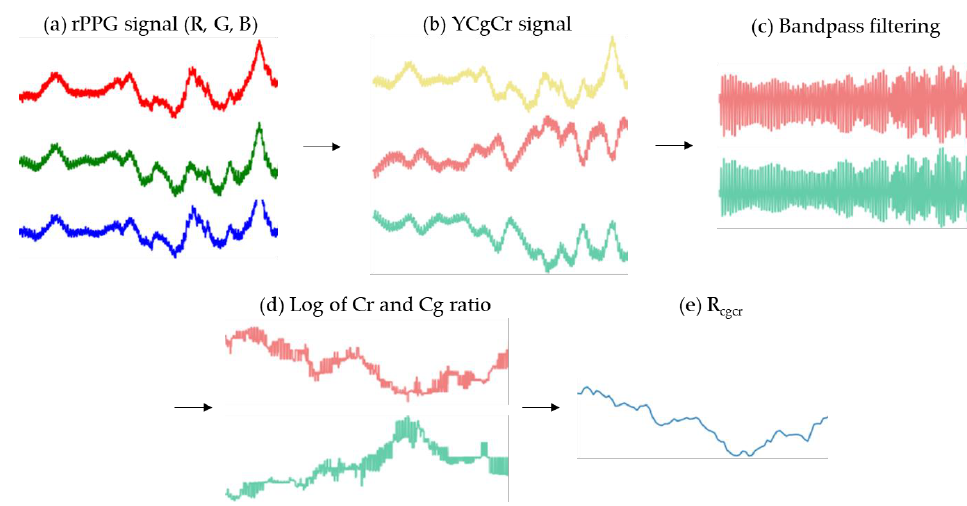
Figure 4. Process of extracting R cgcr value from rPPG signal ( a ) R, G, B signals extracted from face ROI. The red line is the R raw signal, the green line is the G raw signal, and the blue line is B raw signal. ( b ) R, G, B signals are converted into YCgCr color space. The yellow line is the Y signal, the pink line is the Cr signal, and the light blue line is the Cg signal. ( c ) Result of bandpass filtering on Cg and Cr signals. The pink line is the filtered Cr signal, the light blue line is the filtered Cg signal. ( d ) The result of Equations (8) and (9). That is, the log value of the peak/valley extracted from the Cg and Cr signals to which bandpass filtering is applied, respectively. The pink line is the calculated Cr signal, the light blue line is the calculated Cg signal. ( e ) The result of Equation (10), that is, Cr ratio/Cg ratio.